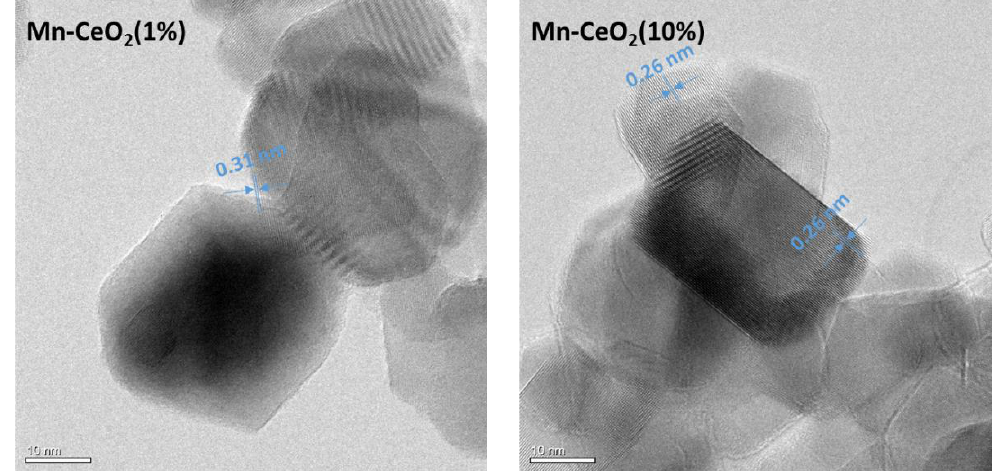
Figure 6. HR-TEM micrograph for Mn-CeO 2 (1%) and Mn-CeO 2 (10%) samples.